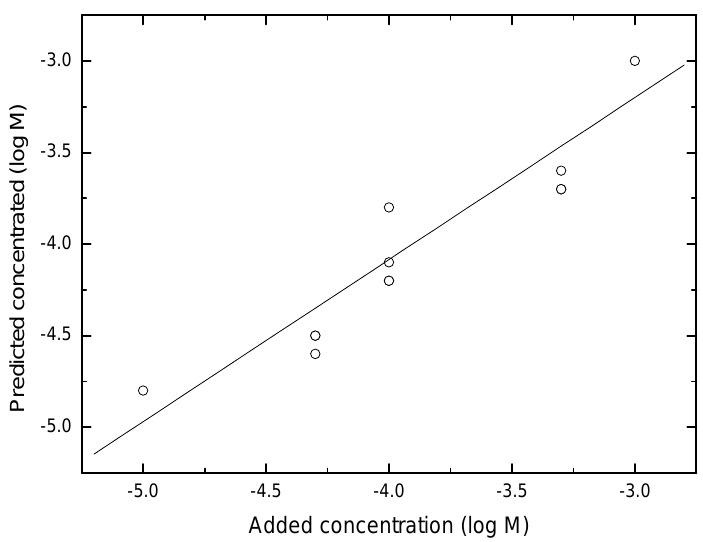
Figure 10. Calibration curve (21 samples) of n-butyrate in test mixtures of key odorants containing ammonium at pH 8. BPNN used 6, 0, 1